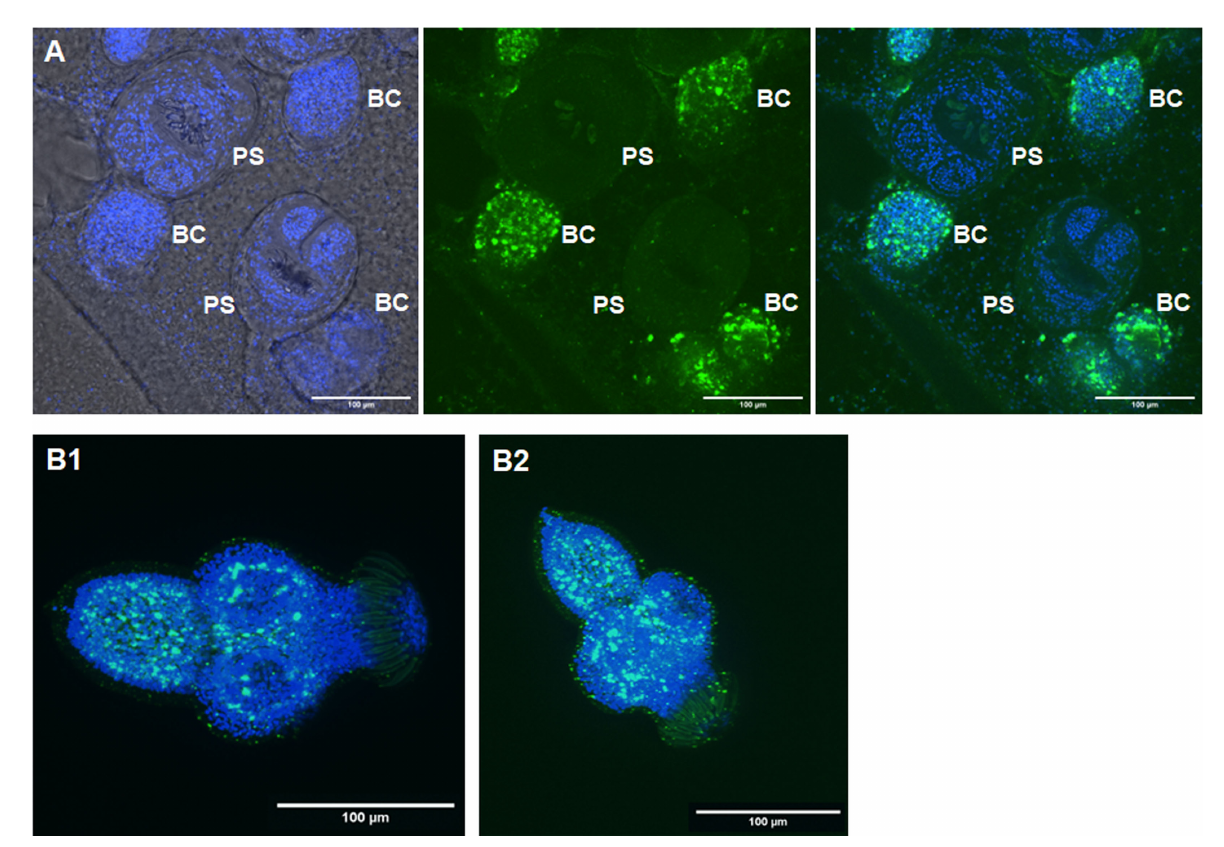
FIGURE 9 Expression of Emact in protoscoleces. (A) shows a representative WISH analysis of Emact expression in dormant protoscoleces (PS). Left channels is DAPI (nuclei, blue), middle channel is Emact signal (green), right is merge of both channels. Bar represents 100 µm. Please note strong Emact signals in BC immediately adjacent to dormant PS. (B1, B2) , two examples of representative WISH images for Emact expression in activated PS. Displayed are ImageJ 3D projects of 20 stacks. DAPI (nuclei, blue) and Emact (green) are merged. Bar represents 100